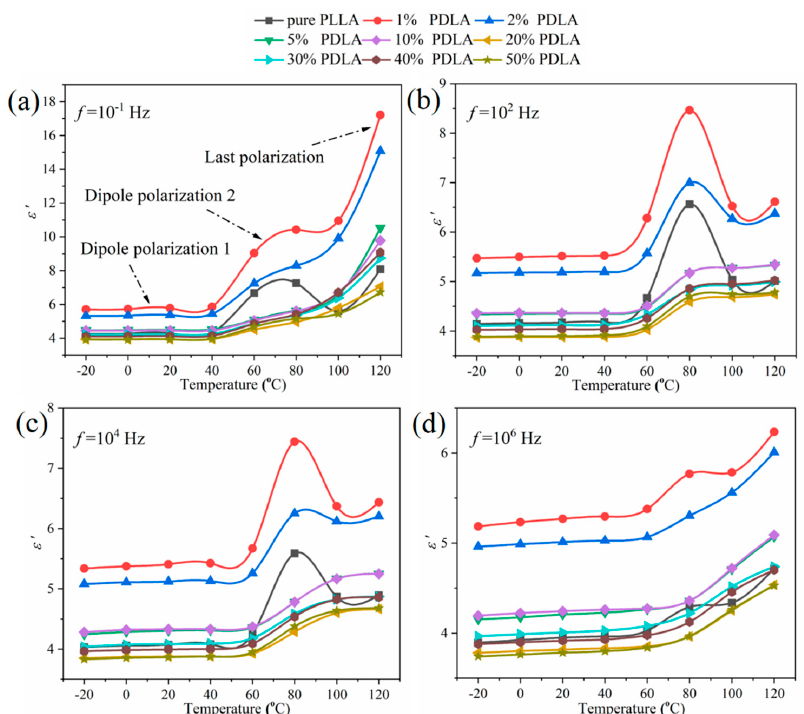
Figure 6. Temperature dependence of the dielectric constant of pure PLLA and PDLA/PLLA blends with different PDLA contents on the ( a ) 10 − 1 , ( b ) 10 2 ( c ) 10 4 , and ( d ) 10 6 Hz, respectively.